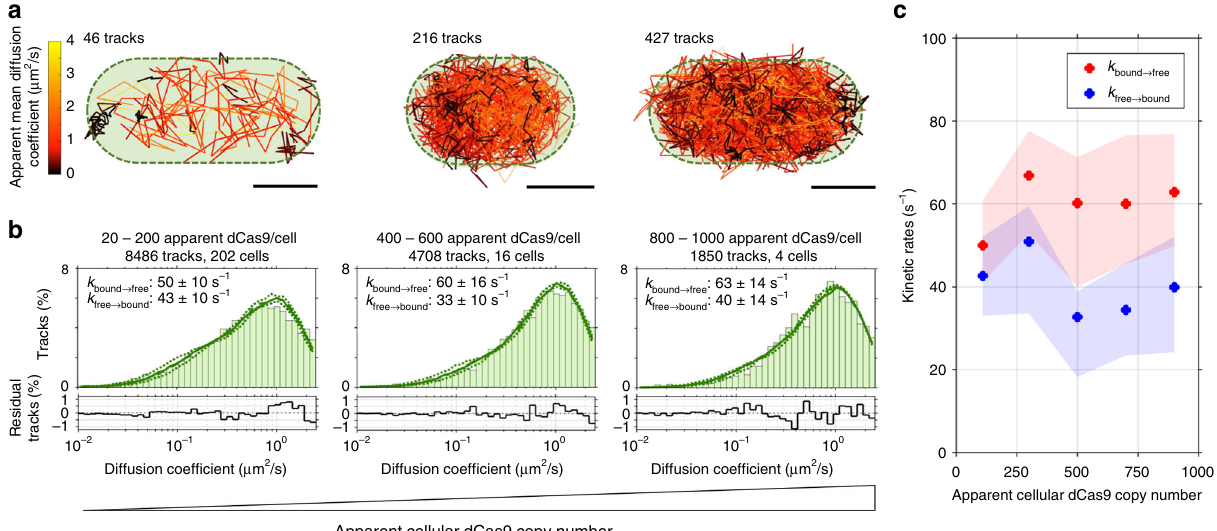
Fig. 2 sptPALM of dCas9-PAmCherry2 in pNonTarget L. lactis with increasing dCas9 concentration. a Identi fi ed tracks in single pNonTarget L. lactis cells. Tracks are colour-coded based on their diffusion coef fi cient. Three separate cells are shown with increasing cellular concentration of dCas9. Green dotted outline is an indication for the cell membrane. Scale bars represent 500 nm. b Diffusion coef fi cient histograms (light green) belonging to 20 – 200, 400 – 600, and 800 – 1000 dCas9 copy numbers, from left to right. Histograms are fi tted (dark green line) with a theoretical description of state- transitioning particles between a mobile and immobile state (dashed line represents 95% con fi dence interval based on bootstrapping the original data). Five diffusion coef fi cient histograms (Supplementary Fig. 4) were globally fi tted with a single free diffusion coef fi cient (2.0 ± 0.1 µ m 2 /s; mean ± standard deviation), a single value for the localization error ( σ = 38 ± 3 nm = 0.15 ± 0.03 µ m 2 /s), and 5 sets of k bound → free and k free → bound values (indicated in the fi gures). Residuals of the fi t are indicated below the respective distribution. c k k bound → free (red) and free → bound (blue) plotted as function of the apparent cellular dCas9 copy number. Solid dots show the fi ts of the actual data; fi lled areas indicate the 95% con fi dence intervals obtained from the bootstrapped iterations of fi tted MC-DDAs with 20,000 simulated proteins. Source data are provided as a Source Data fi